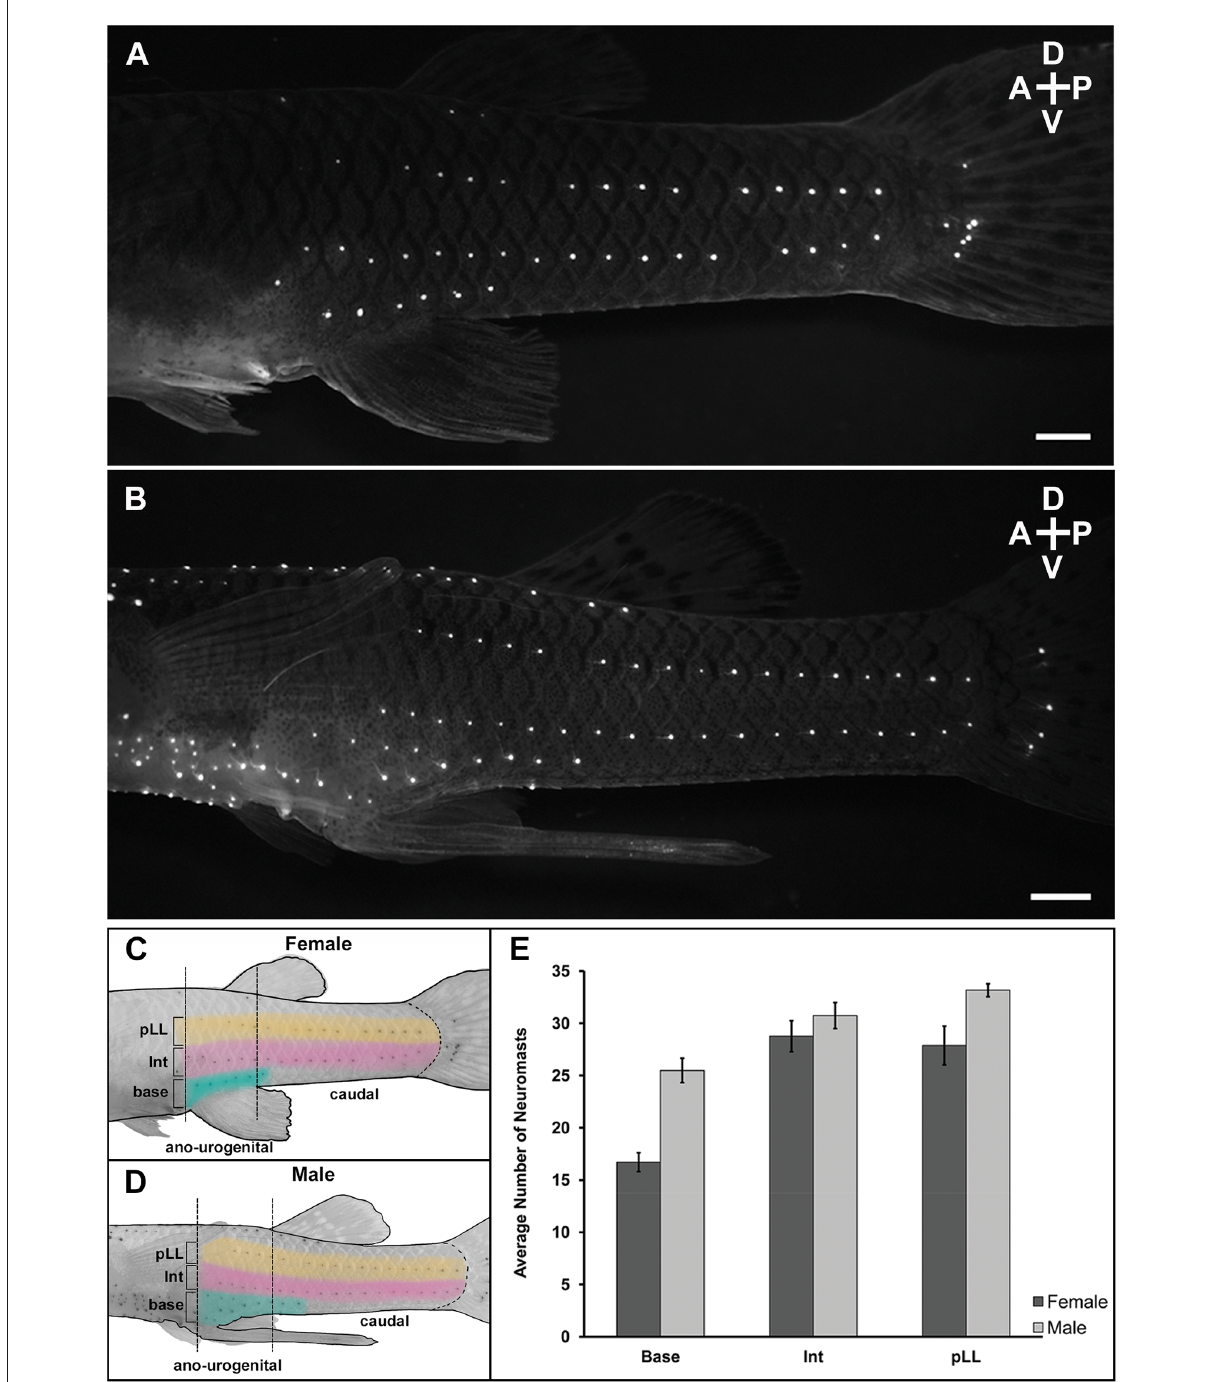
FIGURE2 Lateral view of superficial neuromast labeling at the ano-urogenital and caudal regions of mosquitofish. Adult female ( n = 12) and adult male ( n = 12) were immersed with 10 µ M solution of the fluorescent dye 4-Di-2-asp (10 µ M solution) dissolved in distilled water overnight at 20 ◦ C in a darkened room to minimize stress. The next day, the mosquitofish were washed six times (5 min each) in clean water in the dark, anesthetized with Benzocaine diluted in water (1:2,000), placed in a shallow Petri dish with water and visualized using a Leica MZ-16 FA stereo fluorescence microscope with a 488 nm excitation filter. (A) 28 mm SL female and (B) 25 mm SL male mosquitofish. Scale bars = 10 µ m. A, anterior; P, posterior; D, dorsal; V, ventral. Panels (C) and (D) are graphics of female and male mosquitofish showing the superficial neuromast labeling pattern and the three sections quantified within two anatomical regions (ano-urogenital and caudal) previously described for G. affinis ; (base) base of the anal fin